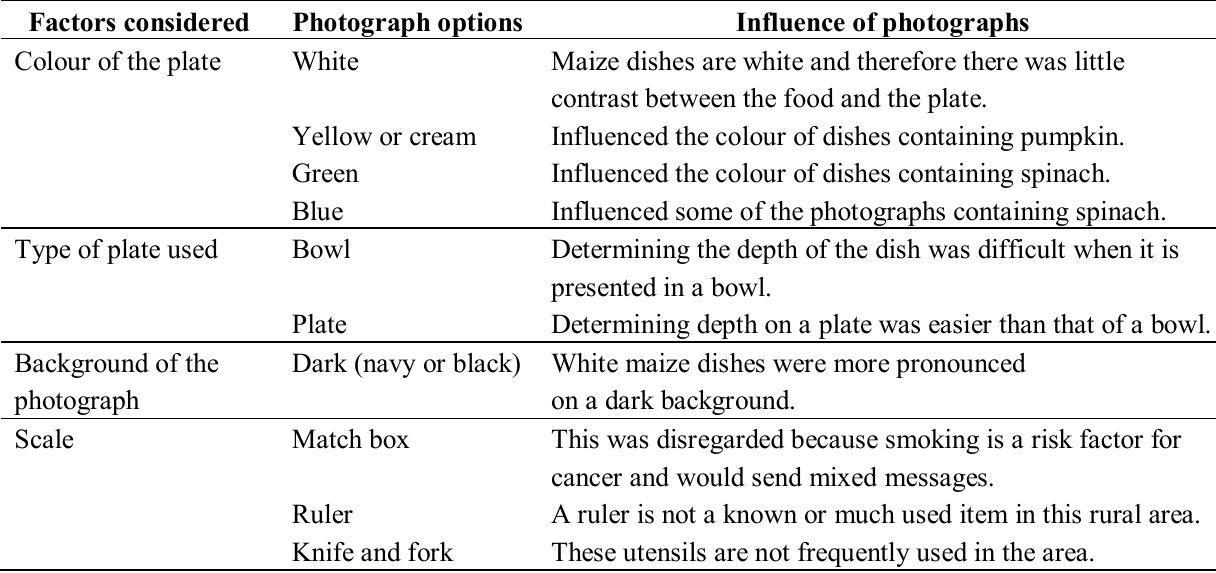
Table 1. Different factors considered in developing the